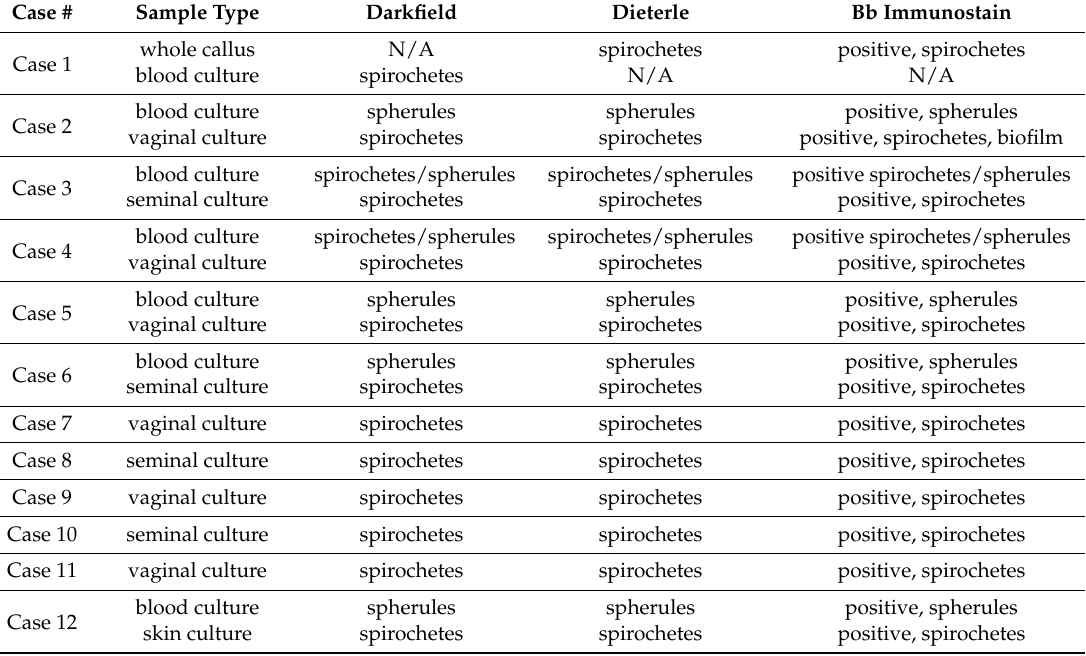
Table 3. Summary of Microscopy Results from Patient Culture Samples.